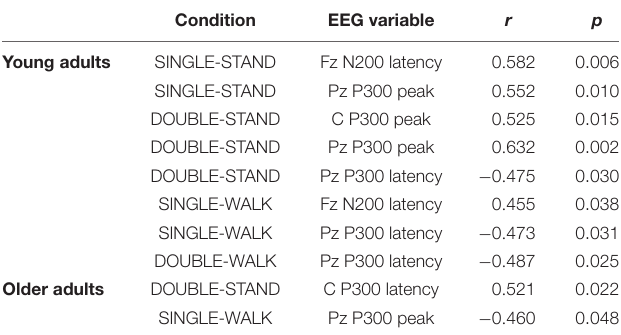
TABLE 1 | Pearson correlation coefficients (r) and significance values (p) from the correlations between reaction time and EEG variables during single stimulus while standing (SINGLE-STAND), single stimulus while walking (SINGLE-WALK), double stimuli while standing (DOUBLE-STAND), double stimuli while walking (DOUBLE-WALK) for younger and older